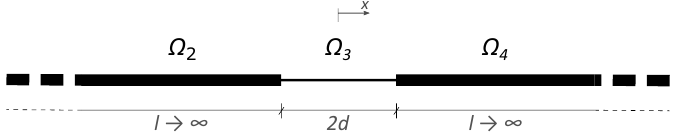
Figure 4. Sketch of the studied limit case. The barriers are infinitely extended toward − ∞ and + ∞